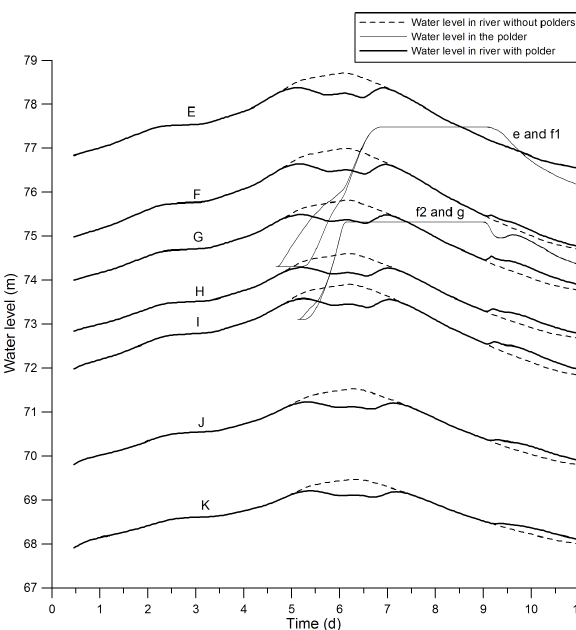
Fig. 10. Water levels in the river and polder system P1+P3 with the weir breadth of 100m. See Fig. 3 for river locations E to K.